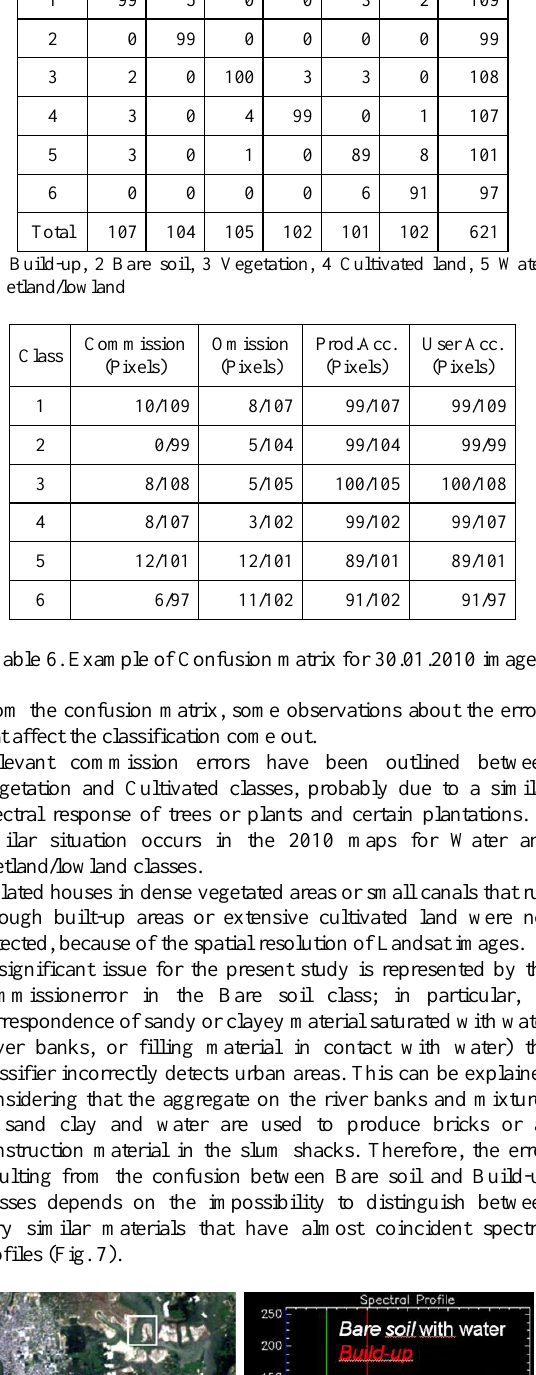
Figure 9. Land use/cover class statistics (km 2 ) The urban growth is the main cause of the reduction of cultivated areas; in fact, as can be seen from the land use/cover changes matrix (Tab. 8), Build up class increased by 35,7 km 2 , the 92% (32,8 km 2 ) of which, in 2000, were cultivated fields (Fig.